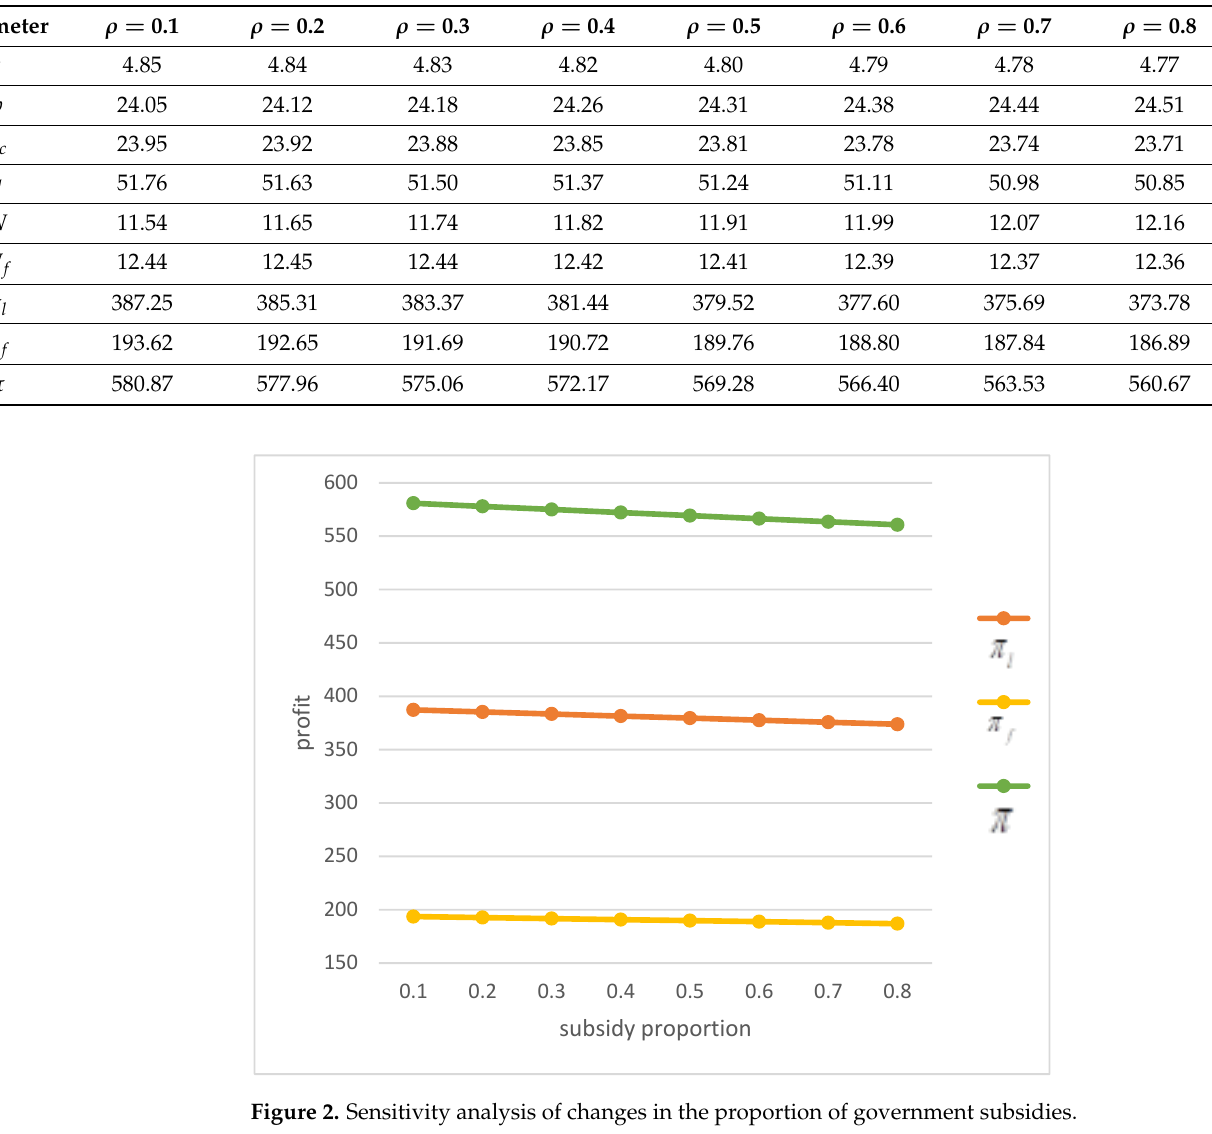
Table 10. Sensitivity analysis of changes in government subsidy proportion.